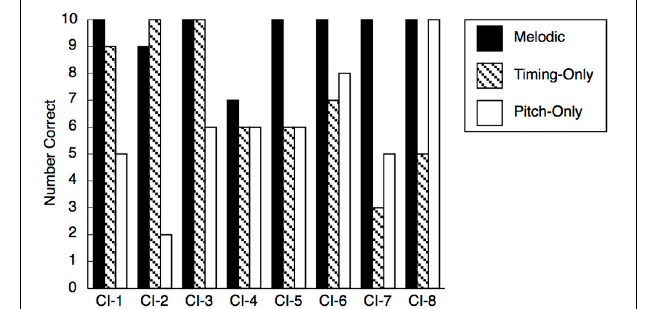
FIGURE 3 | Performance of individual CI users in the melodic, timing-only, and pitch-only